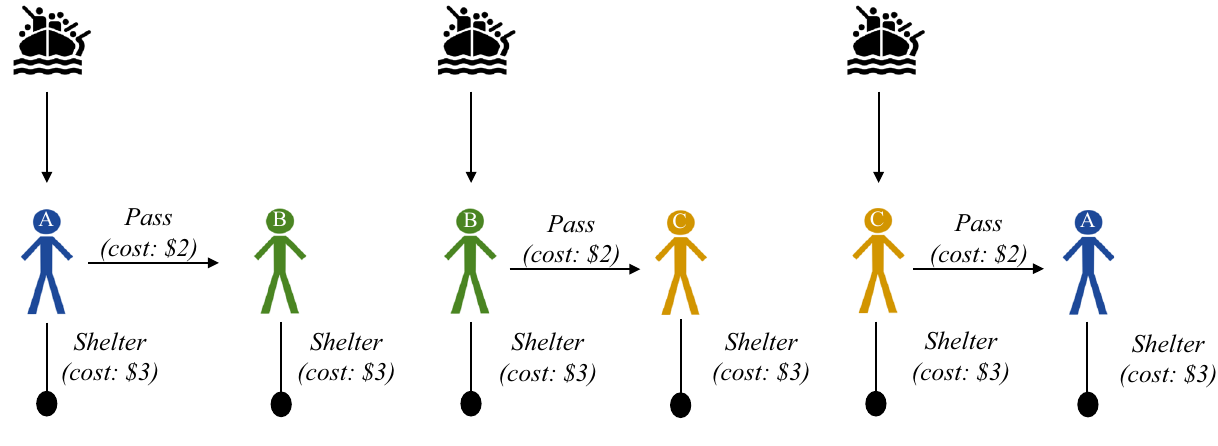
Figure 2. Pass the buck when migrants arrive